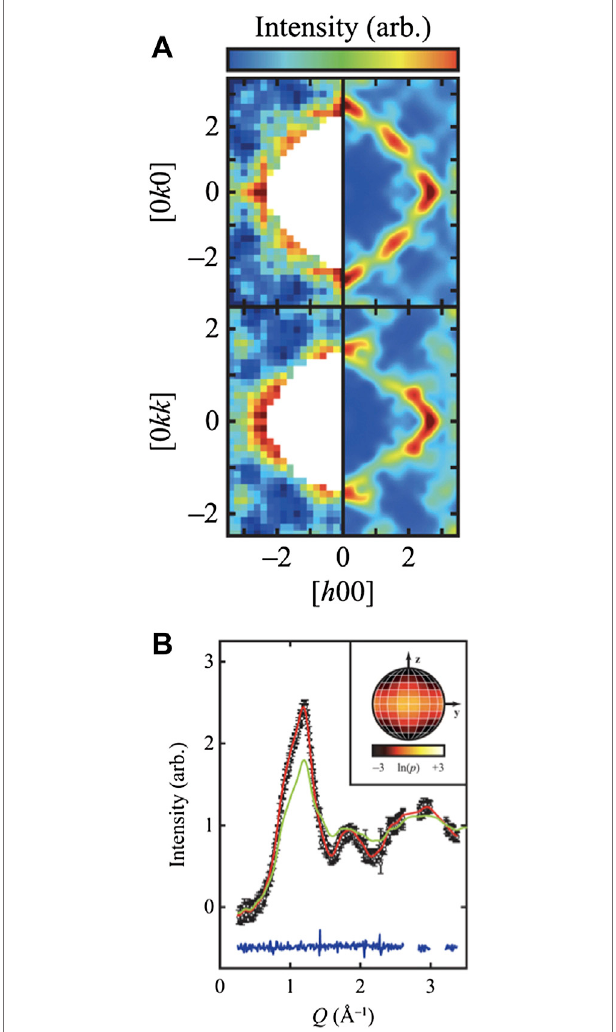
FIGURE 7 | (A) Single-crystal magnetic diffuse scattering, S(Q), in two reciprocal-space planes. The upper image, shows the [h k 0] plane, and the lower image shows the [h k k] plane. In each image, the left panel shows experimental data and the right panel shows the calculation from RMC re fi nements described in the text. Regionswhere there are no data are shown in white [4]. (B) RMC fi t to powder diffuse-scattering data [11]. Data shown as blackcircles, fi tasaredlineanddifference( fi t-data)asablueline.Greenlineis a scattering function from an alternative isotropic model [4].